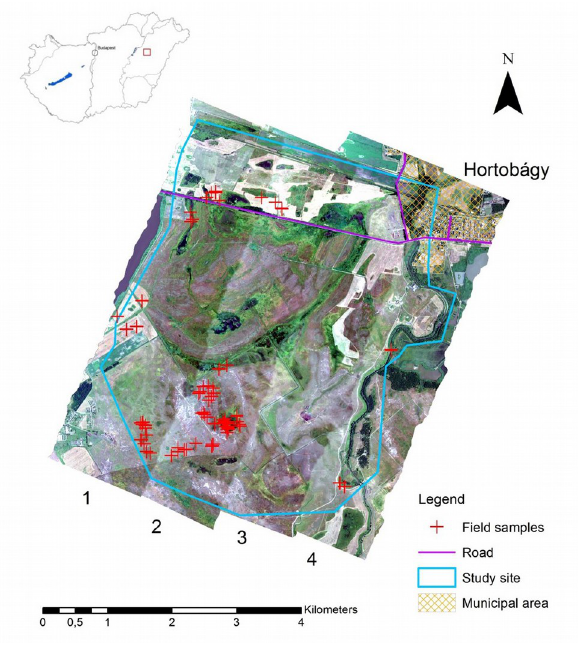
Table 1. Abbreviations of vegetation classes and the name of the studied plant